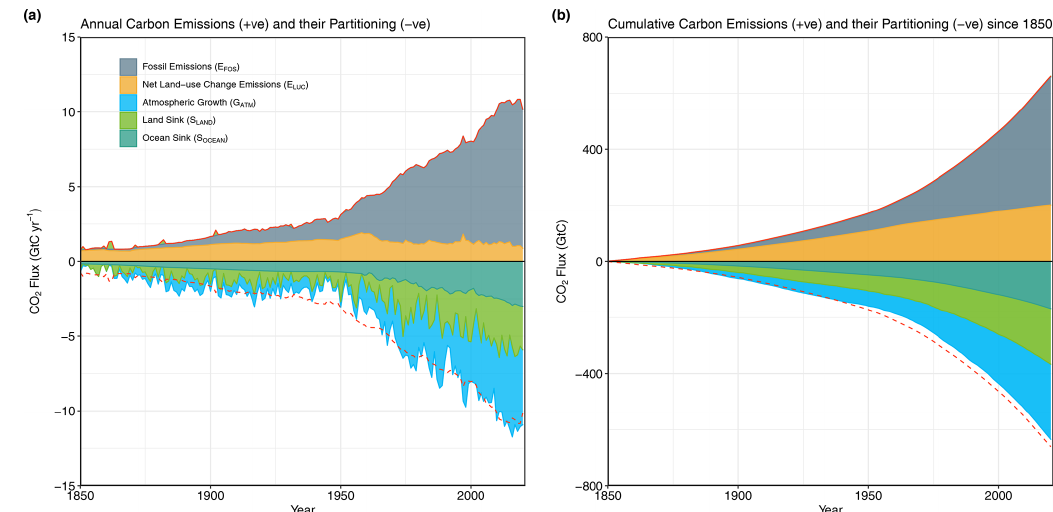
Figure 3. Combined components of the global carbon budget illustrated in Fig. 2 as a function of time, for fossil CO 2 emissions ( E FOS , including a small sink from cement carbonation; grey) and emissions from land-use change ( E LUC ; brown), as well as their partitioning among the atmosphere ( G ATM ; cyan), ocean ( S OCEAN ; blue), and land ( S LAND ; green). Panel (a) shows annual estimates of each flux and panel (b) the cumulative flux (the sum of all prior annual fluxes) since the year 1850. The partitioning is based on nearly independent estimates from observations (for G ATM ) and from process model ensembles constrained by data (for S OCEAN and S LAND ) and does not exactly add up to the sum of the emissions, resulting in a budget imbalance (BI M ) which is represented by the difference between the bottom red line (mirroring total emissions) and the sum of carbon fluxes in the ocean, land, and atmosphere reservoirs. All data are in GtCyr − 1 (a) andGtC (b) . The E FOS estimates are primarily from Gilfillan and Marland (2021), with uncertainty of about ± 5% ( ± 1 σ ). The E LUC estimates are from three bookkeeping models (Table 4) with uncertainties of about ± 0.7GtCyr − 1 . The G ATM estimates prior to 1959 are from Joos and Spahni (2008) with uncertainties equivalent to about ± 0.1–0.15GtCyr − 1 and from Dlugokencky and Tans (2022) since 1959 with uncertainties of about ± 0.07GtCyr − 1 during 1959–1979 and ± 0.02GtCyr − 1 since 1980. The S OCEAN estimate is the average from Khatiwala et al. (2013) and DeVries (2014) with uncertainty of about ± 30% prior to 1959, and the average of an ensemble of models and an ensemble of f CO 2 data products (Table 4) with uncertainties of about ± 0.4GtCyr − 1 since 1959. The S LAND estimate is the average of an ensemble of models (Table 4) with uncertainties of about ± 1GtCyr − 1 . See the text for more details of each component and their